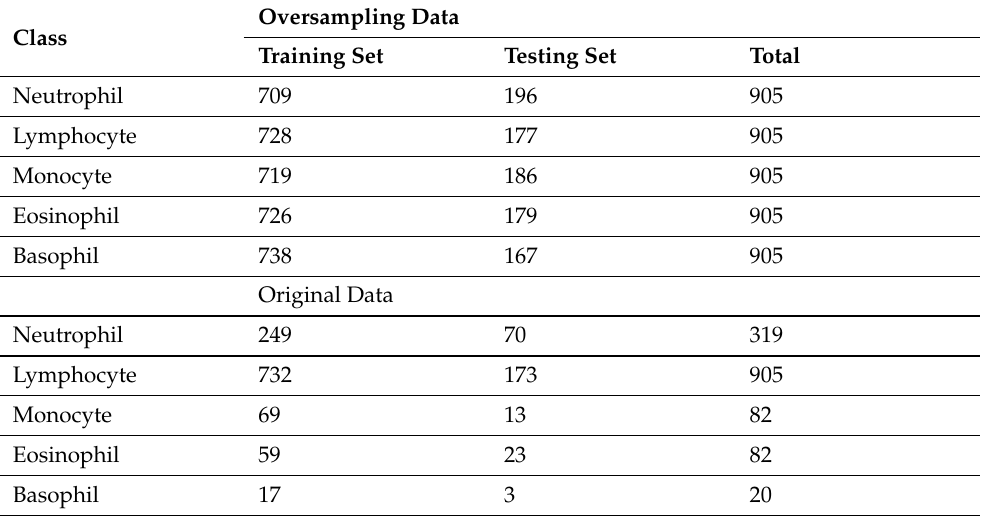
Table 6. Target class count in the training and testing